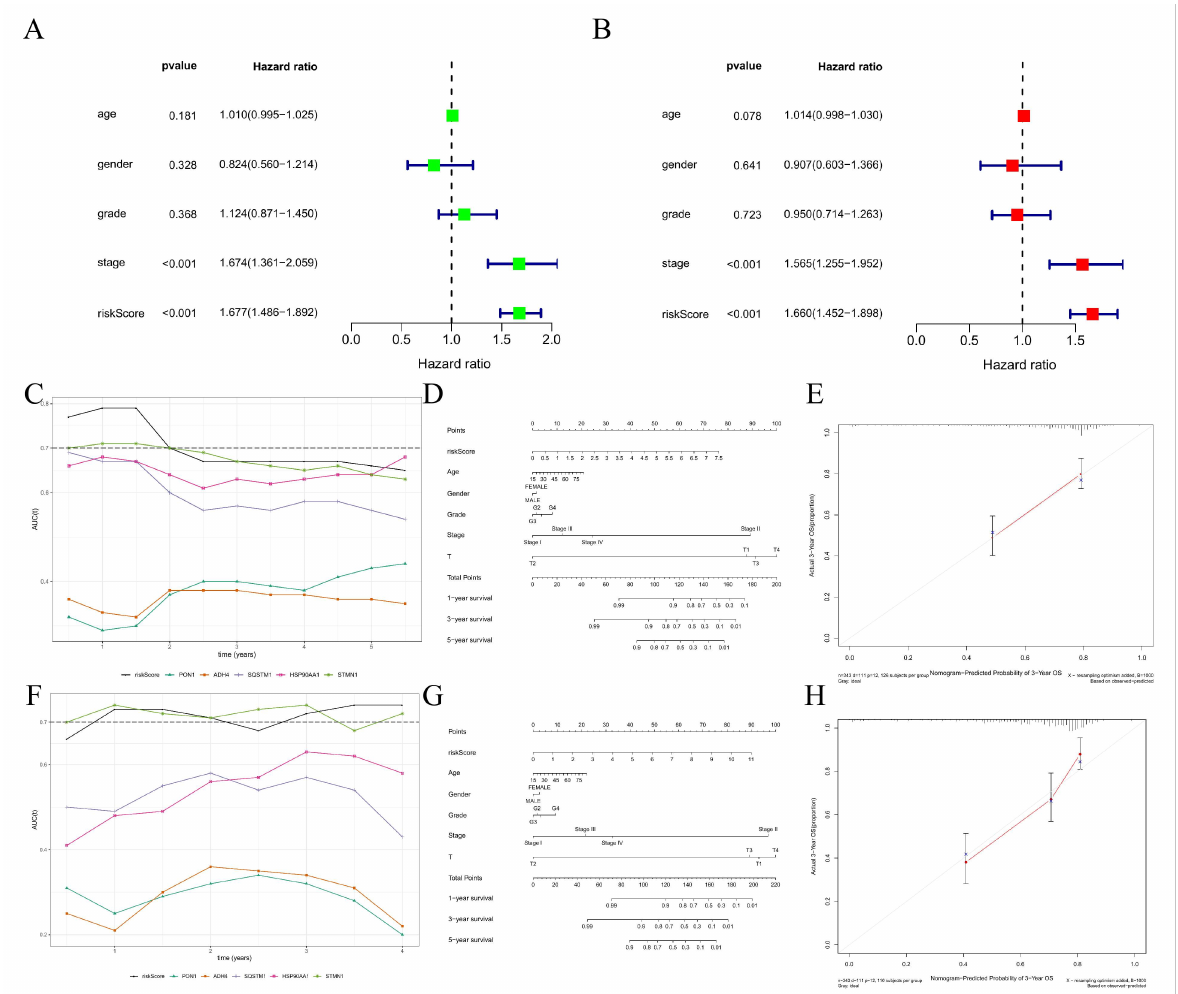
Figure 5. Construction and efficiency evaluation of a DRGPI-based nomogram. ( A ) Univariate Cox regression analysis. ( B ) Multivariate Cox regression analysis. ( C ) The results of AUC values of multiple indexes at multiple time points showed in TCGA cohorts. The nomogram ( D ) and its 3-year calibration curve ( E ) in TCGA cohorts. ( F ) The results of AUC values of multiple indexes at multiple time points showed in ICGC cohorts. The nomogram ( G ) and its 3-year calibration curve ( H ) in the ICGC cohort. Table 1. Multivariate Cox proportional hazards regression model including the key members of the DRGPI for overall survival in patients with HCC. 95%CL p -Value Gene Coefficient HR Lower Upper PON1 −